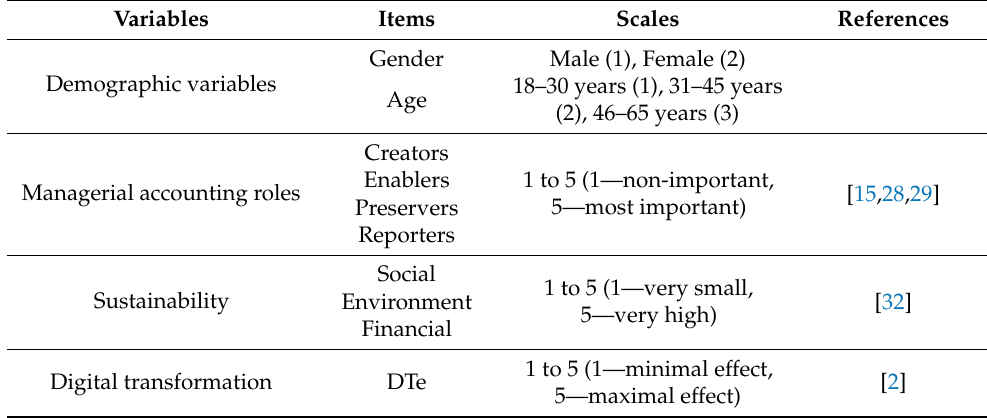
Table 1. Questionnaire structure.